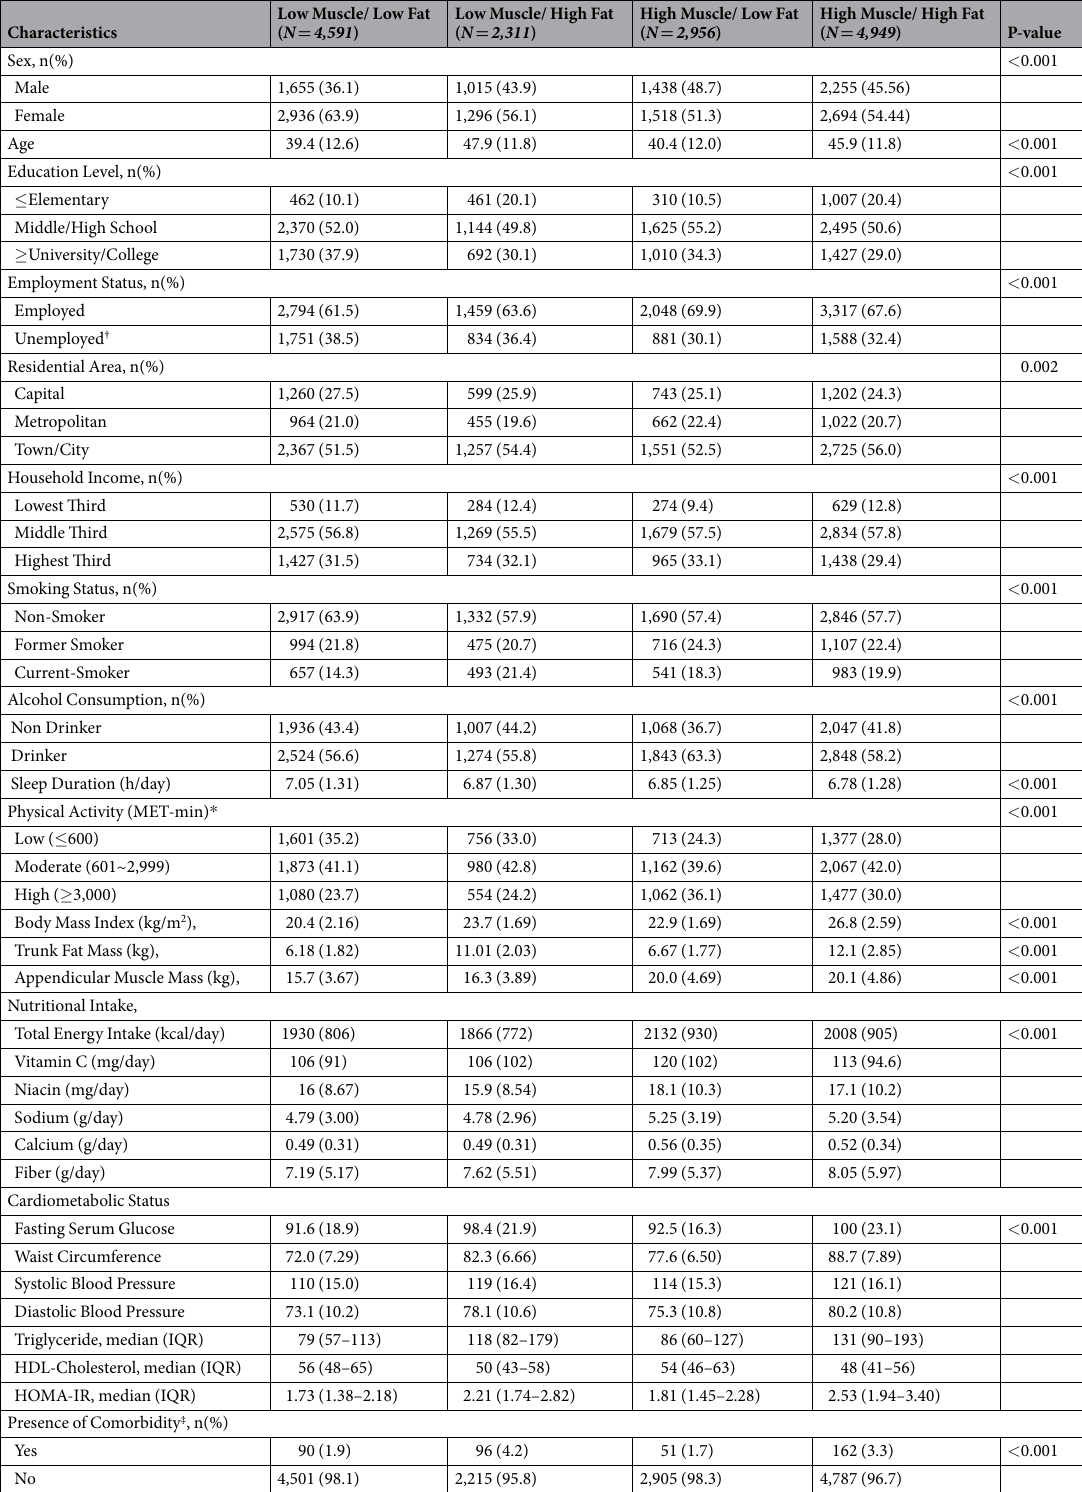
Table 1. Sociodemographic, health-related, and clinical characteristics of the participants by muscle mass and fat mass among the participants of the KNHANES IV-V from 2008 to 2011. All values are presented as mean (SD) unless otherwise stated. P value from ANOVA for continuous variables and Chi-Square test for categorical variables. * MET minutes from IPAQ. † Includes individuals who are students and housewives at the time of